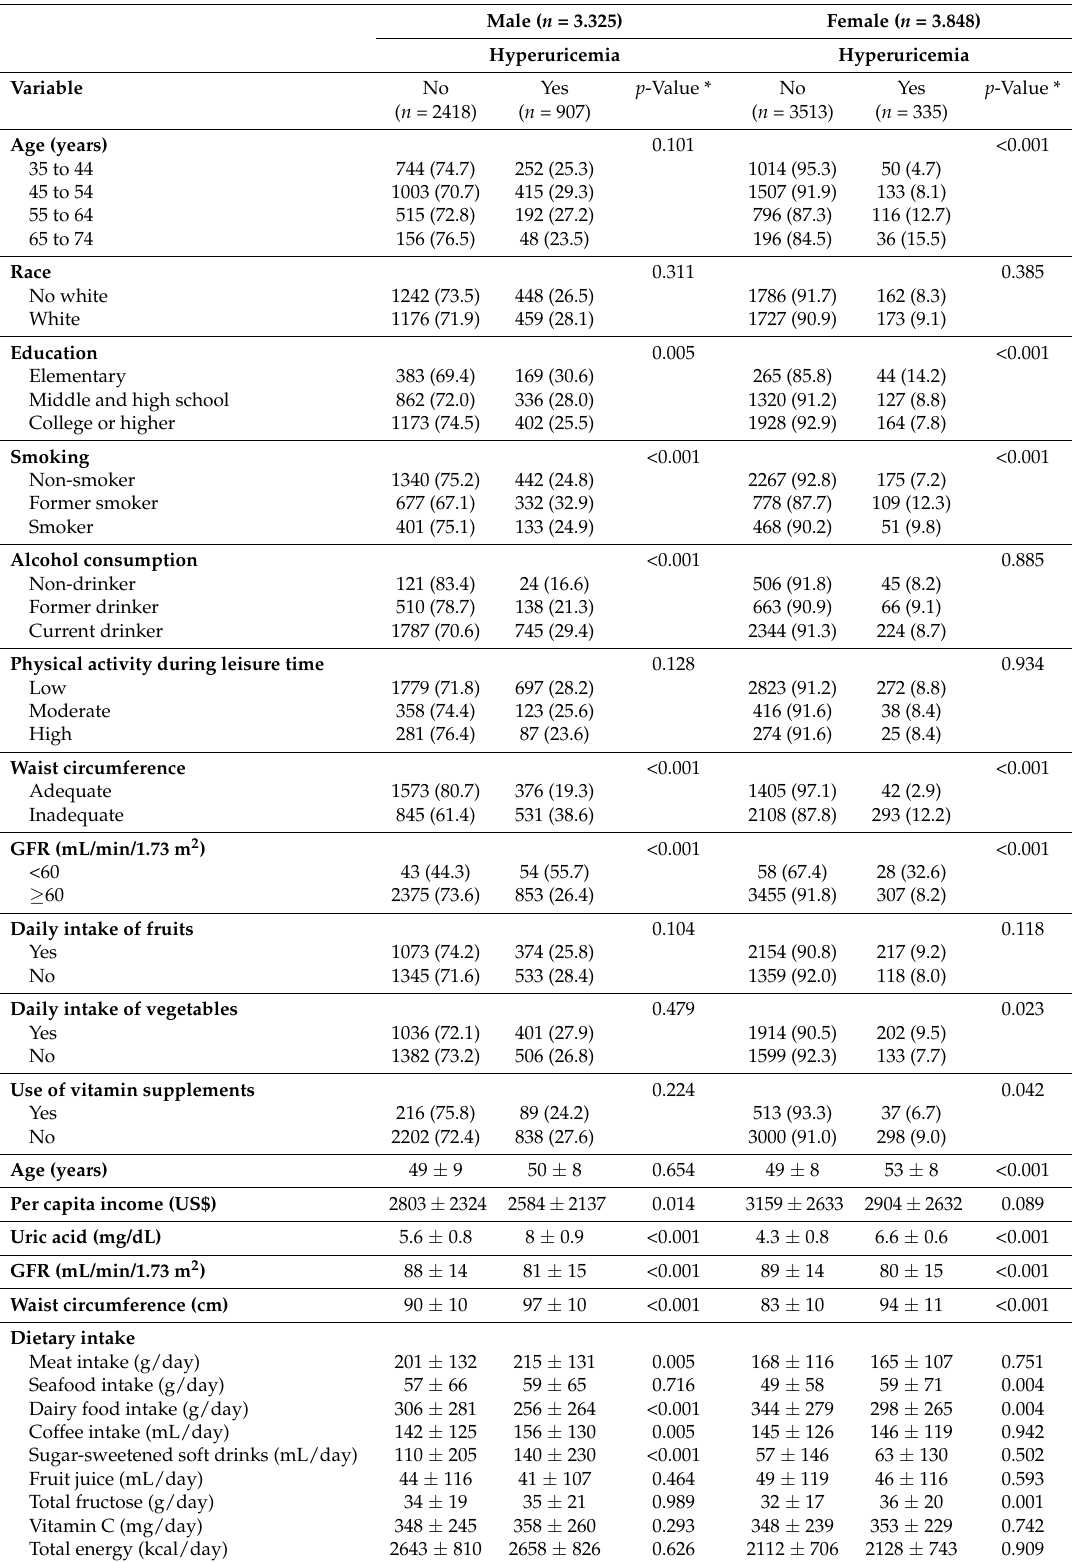
Table 2. Characteristics according to hyperuricemia status. ELSA-Brasil,